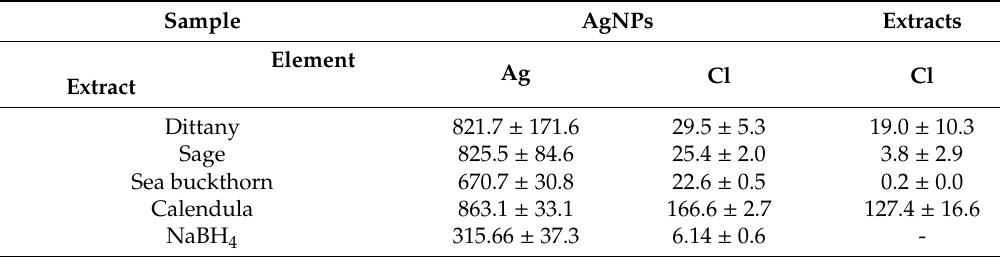
Table 2. Concentration (ppm) of Ag and Cl in AgNPs and extracts (mean values ± SD). Sample AgNPs